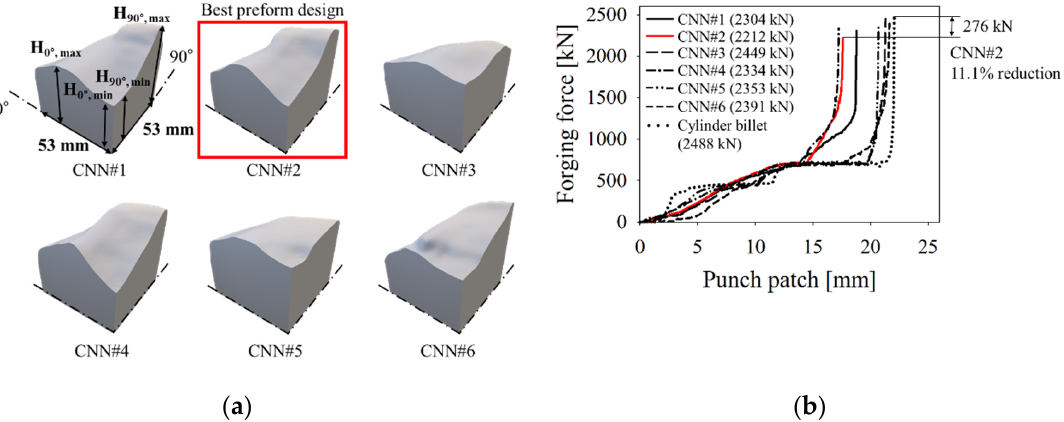
Figure 12. ( a ) Preform geometries for the symmetric forging and ( b ) forging force–punch patch comparison.